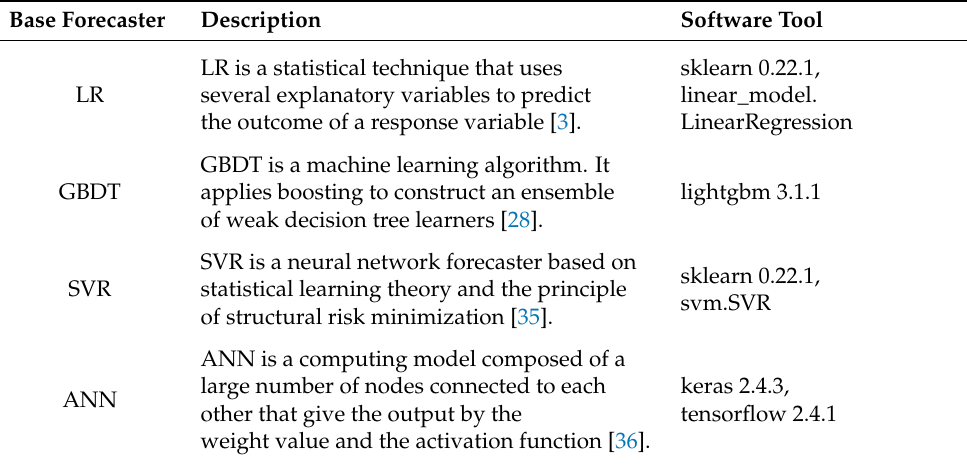
Table 2. The base forecasters for